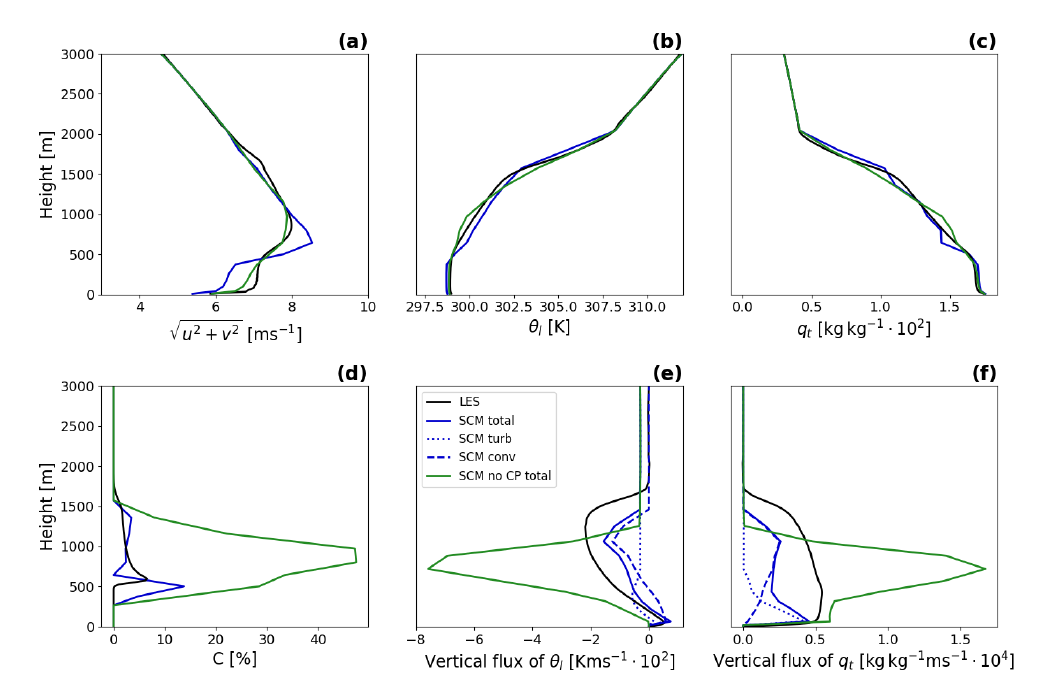
Figure 3. As in Figure 2, but mean vertical profiles of wind speed ( a ), θ l ( b ), q t ( c ), cloud fraction ( d ), and vertical fluxes of θ l and q t from the turbulence scheme and the convection scheme ( e , f ) for the BOMEX case after 5 h of integration.